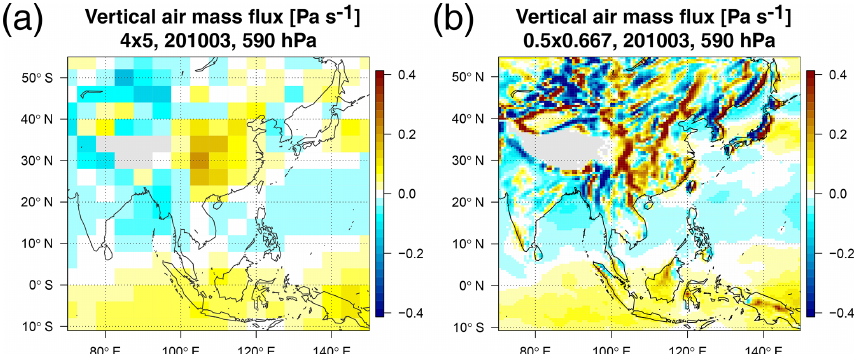
Figure 10. Mean advective vAMFs at 4 ◦ × 5 ◦ and 0 . 5 ◦ × 0 . 67 ◦ resolution in March 2010 at